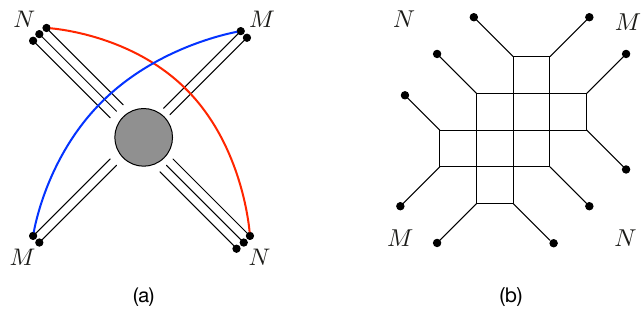
Figure 6. Brane web for the X N 1 ;N 2 theory with N = 3 and M = 2 on the left hand side, and a deformation to a quiver gauge theory on the right hand